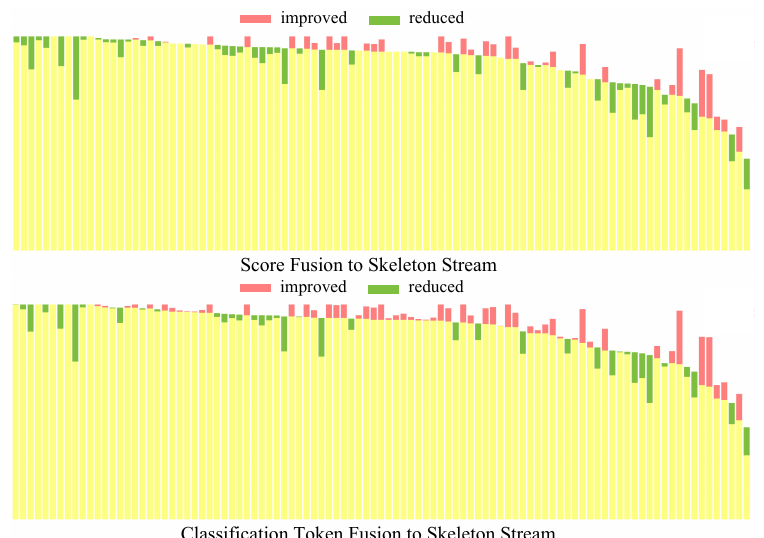
Figure 9. The improvement and reduction to the skeleton stream by different fusion